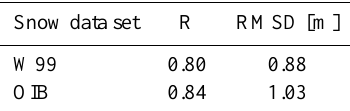
Table 7. Summary of comparison between RA-2 sea ice thickness computed using different snow depth data sets and OIB sea ice thickness for the Fram Strait area for April 2010. Total number of data pairs is N = 13.